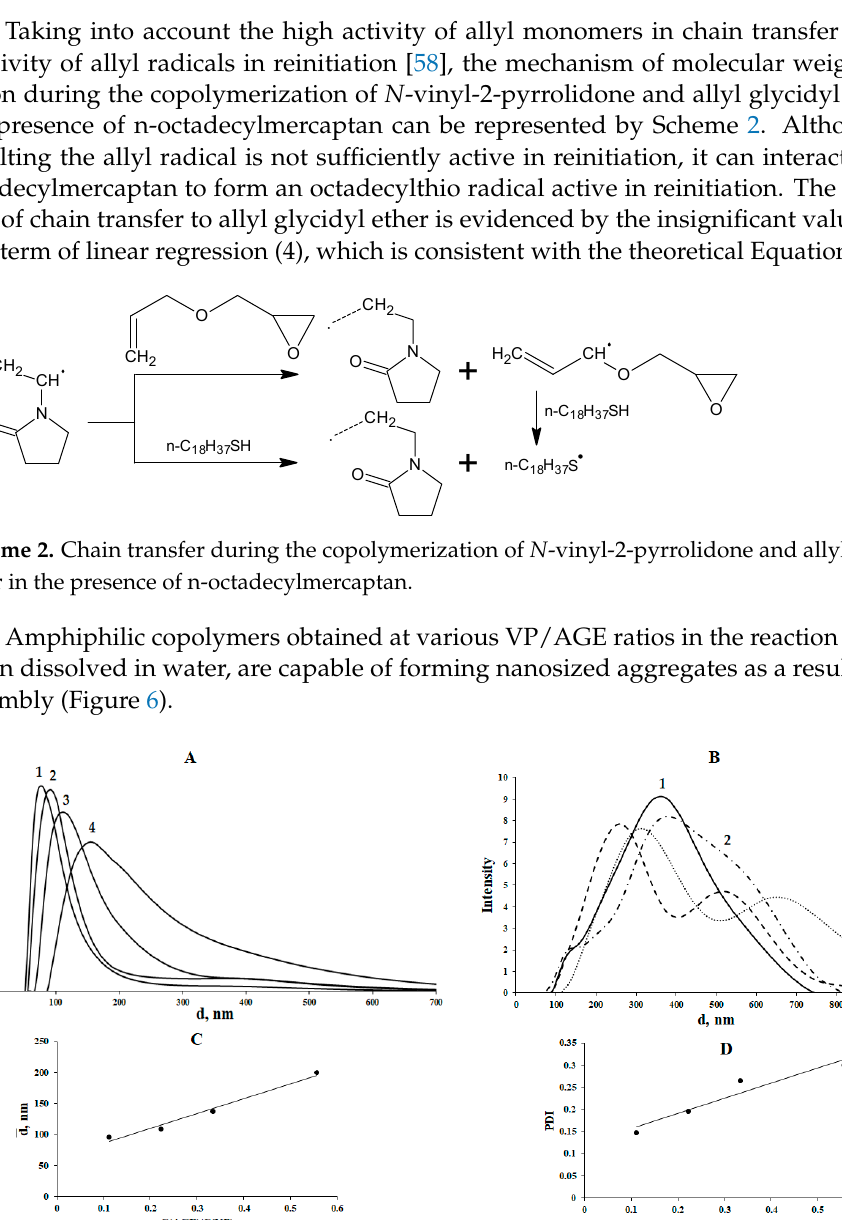
Figure 5. Dependence of the number-average molecular weight of the amphiphilic copolymers of N-vinyl-2-pyrrolidone and allyl glycidyl ether on the ratio of monomers in the reaction system.